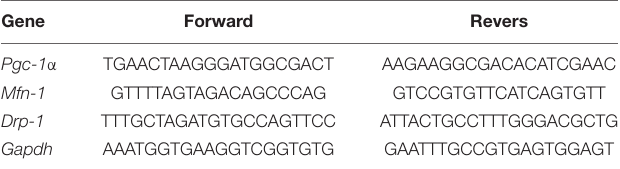
TABLE 2 | Primer sequence (5 (cid:48) → 3 (cid:48)